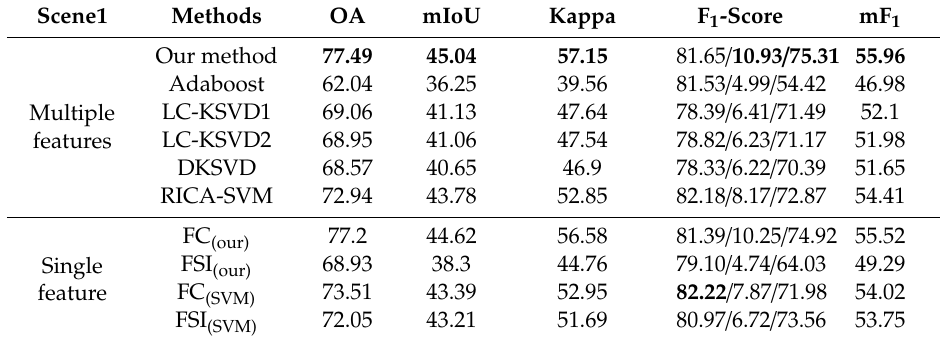
Table 2. Classification results of Scene1 (%). F 1 -score corresponds to the accuracy in terms of buildings, cars and trees. Note that the highest accuracy values are highlighted in bold.